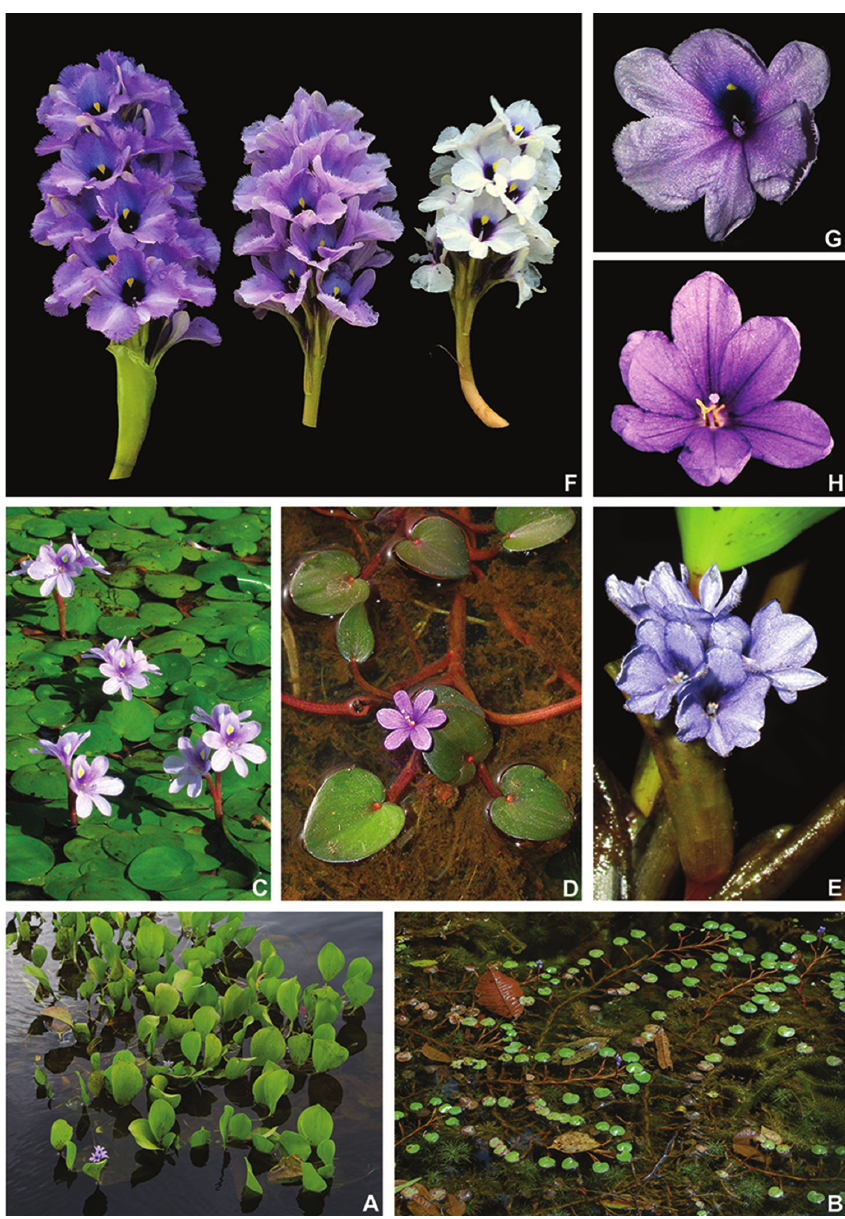
Figure 8. Pontederia subg. Eichhornia (Kunth) M.Pell. & C.N.Horn. A–B habit: A habit of P. hetero- sperma (Alexander) M.Pell. & C.N.Horn, showing the emerged petiolate leaves B habit of P. diversifolia (Vahl) M.Pell. & C.N.Horn, showing the floating petiolate leaves C–F inflorescence: C 2–3-flowered inflorescences of P. diversifolia , showing the flowers with a yellow nectar guide in the posterior perianth lobes D 1-flowered inflorescence of P. natans P.Beauv., showing the lack of a nectar guide E inflorescence of P. heterosperma , showing the lack of nectar guides in the posterior perianth lobes F morphological vari- ation of inflorescences and perianth colour of P. azurea Sw G front view of a flower of P. azurea H front view of a flower of P. natans . A, B by O. Gaubert C by A.S. Castro D by P. Birnbaum E by H. Medeiros F by L.O.A. Teixeira G by M.O.O. Pellegrini and I by T.C.